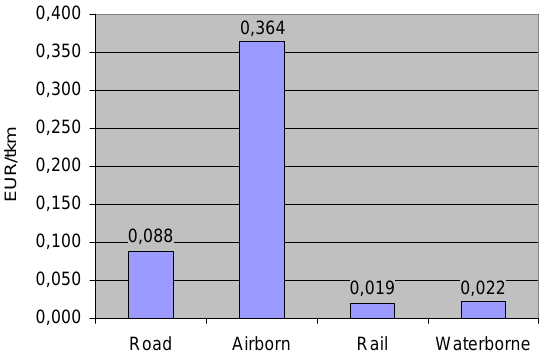
Fig 6. Specific external costs of transport modes in 2000, in EU-15 plus Norway and Switzerland